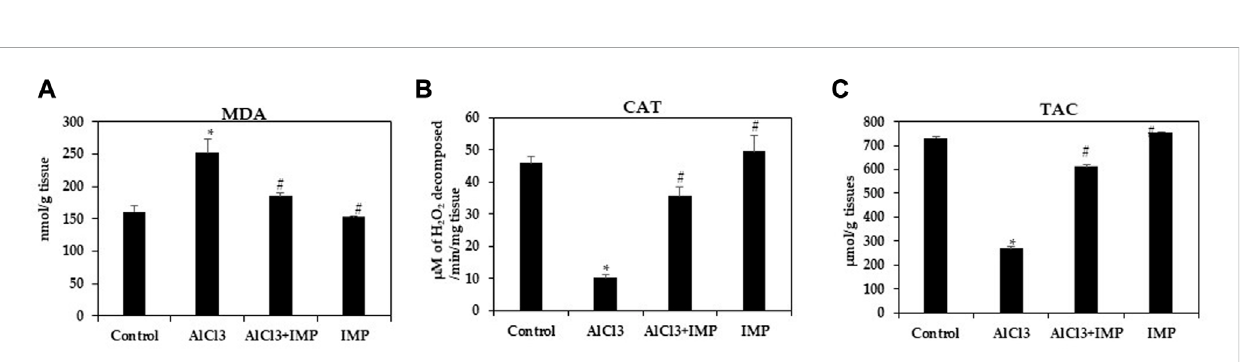
FIGURE 5 Activity of antioxidant enzymes. (A) Formation of MDA in brain homogenates (nmol/g tissue). (B) The activity of catalase (µM of H 2 O 2 decomposed/ min/mg tissue). (C) Totalantioxidantcapacity(µmol/gtissues).Thedifferencebetweenthetreatmentandcontrol groupswasstatisticallysigni fi cant;* p < 0.05, # p < 0.05 wasconsideredstatistically signi fi cant. Values are expressed as mean ±SD, n =3. * p < 0.05 indicates that thereare signi fi cant differences between the AlCl3 alone group and the control group. # p < 0.05 shows signi fi cant differences between AlCl3 alone and IMP with